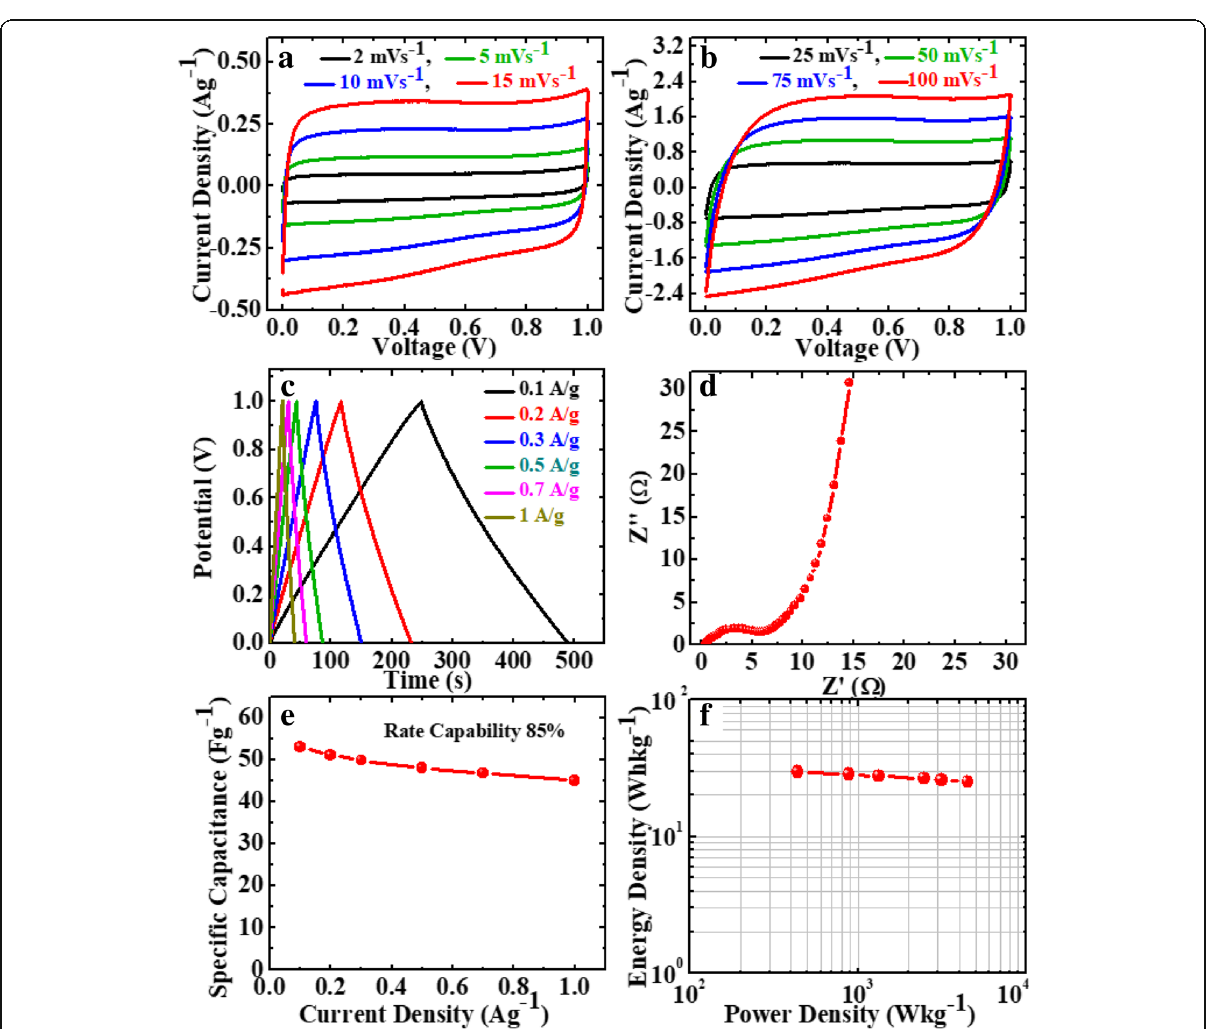
Fig. 12 Electrochemical performance of GP10C/KOH/GP10C symmetrical coin supercapacitor cell a , b CV curves of GP10C/KOH/GP10C coin cell at 2, 5, 10, 15, 25, 50, 75, and 100 mVs − 1 , c Nyquist plot, d GCD curves of the device at different current densities, e SC at different current densities, f Ragone